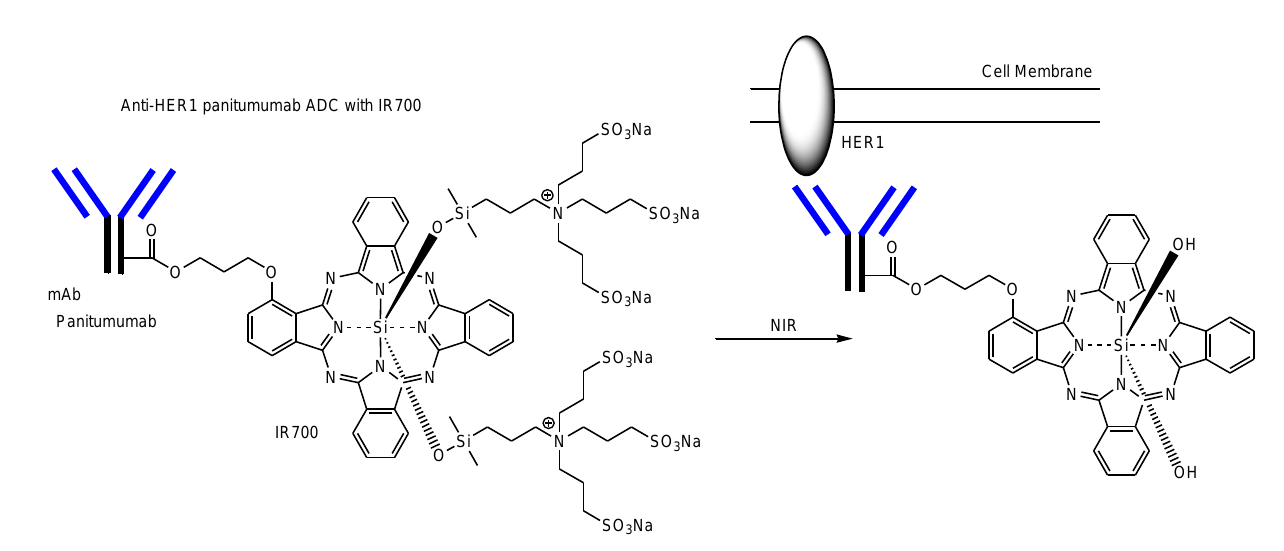
Figure 9. Anti-HER1 panitumumab ADC possessing IR700 with a drug-to-antibody ratio (DAR) of approximately 3 binds HER1 on the surface of cancer cells. At this time, the ADC – HER1 complex is activated by near-infrared (NIR) light (approximately 690 nm) and, consequently, releases its hy- drophilic silanol units from IR700. Resulting hydrophobic complexes are aggregated and induce cytotoxicity by plasma membrane permeabilization.